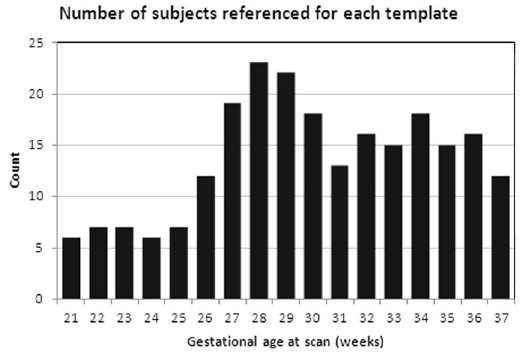
Figure 2. Frequency distribution of subjects contributed to atlas construction at each gestational age point in weeks. The number of subjects used in atlas construction at lower GAs was, on average, smaller than the numbers at higher GAs, which was acceptable as the fetal brain has less features and variability at lower GAs compared to higher